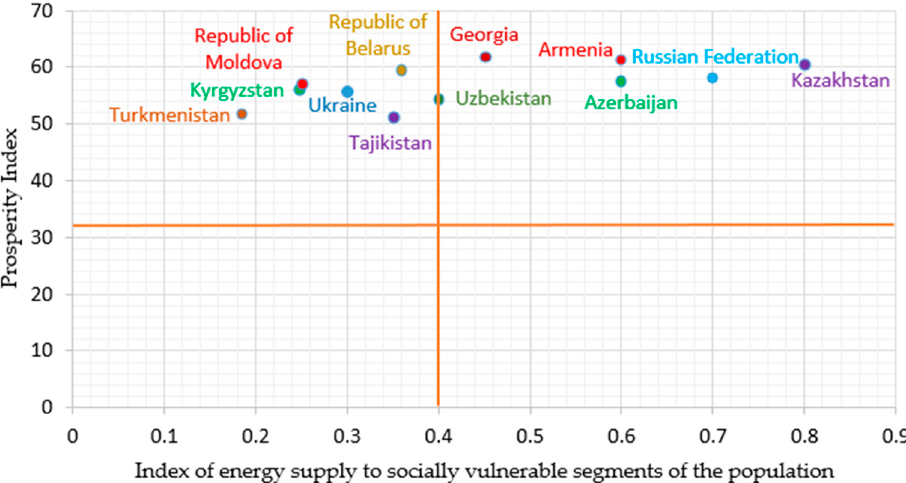
Figure 4. The ratio of the integral index of energy supply to socially vulnerable population segments and the level of well-being of the countries under consideration. Source: developed by the authors based on their own calculations of the energy supply index and the Prosperity Index [39].